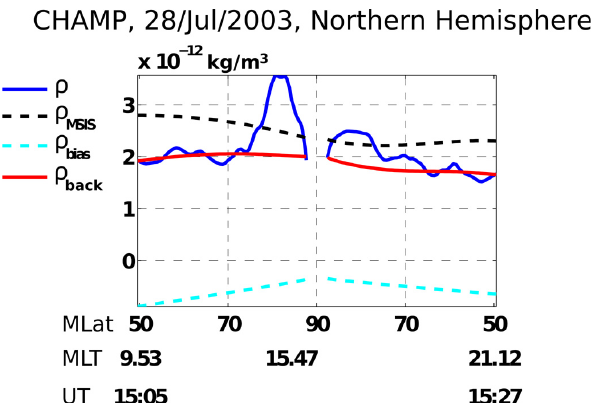
Fig. 1. Example for the background density and relative density en- hancement determination procedures. The blue line indicates den- sity from CHAMP data, the dashed black corresponding model den- sity from NRLMSIS-00, the dashed cyan the linear bias function, and the red line the calculated background ρ back = ρ MSIS + ρ bias